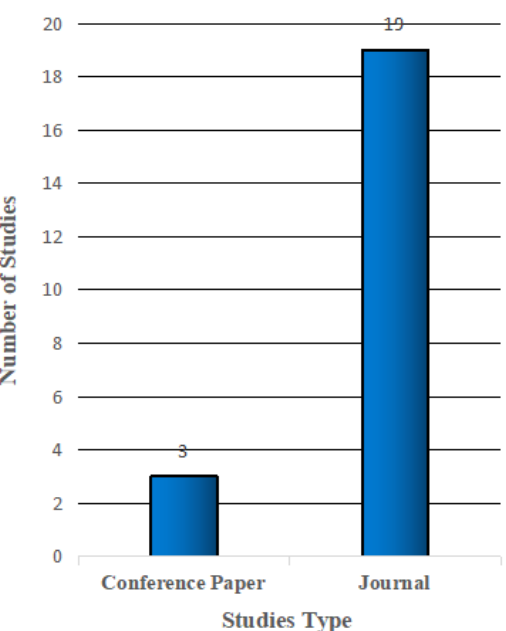
Figure 3. Studies Type Included in Review.